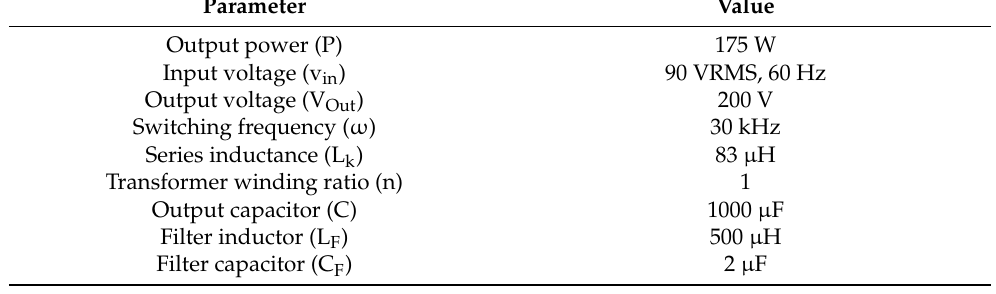
Table 1. AC–DC DAB test parameters.